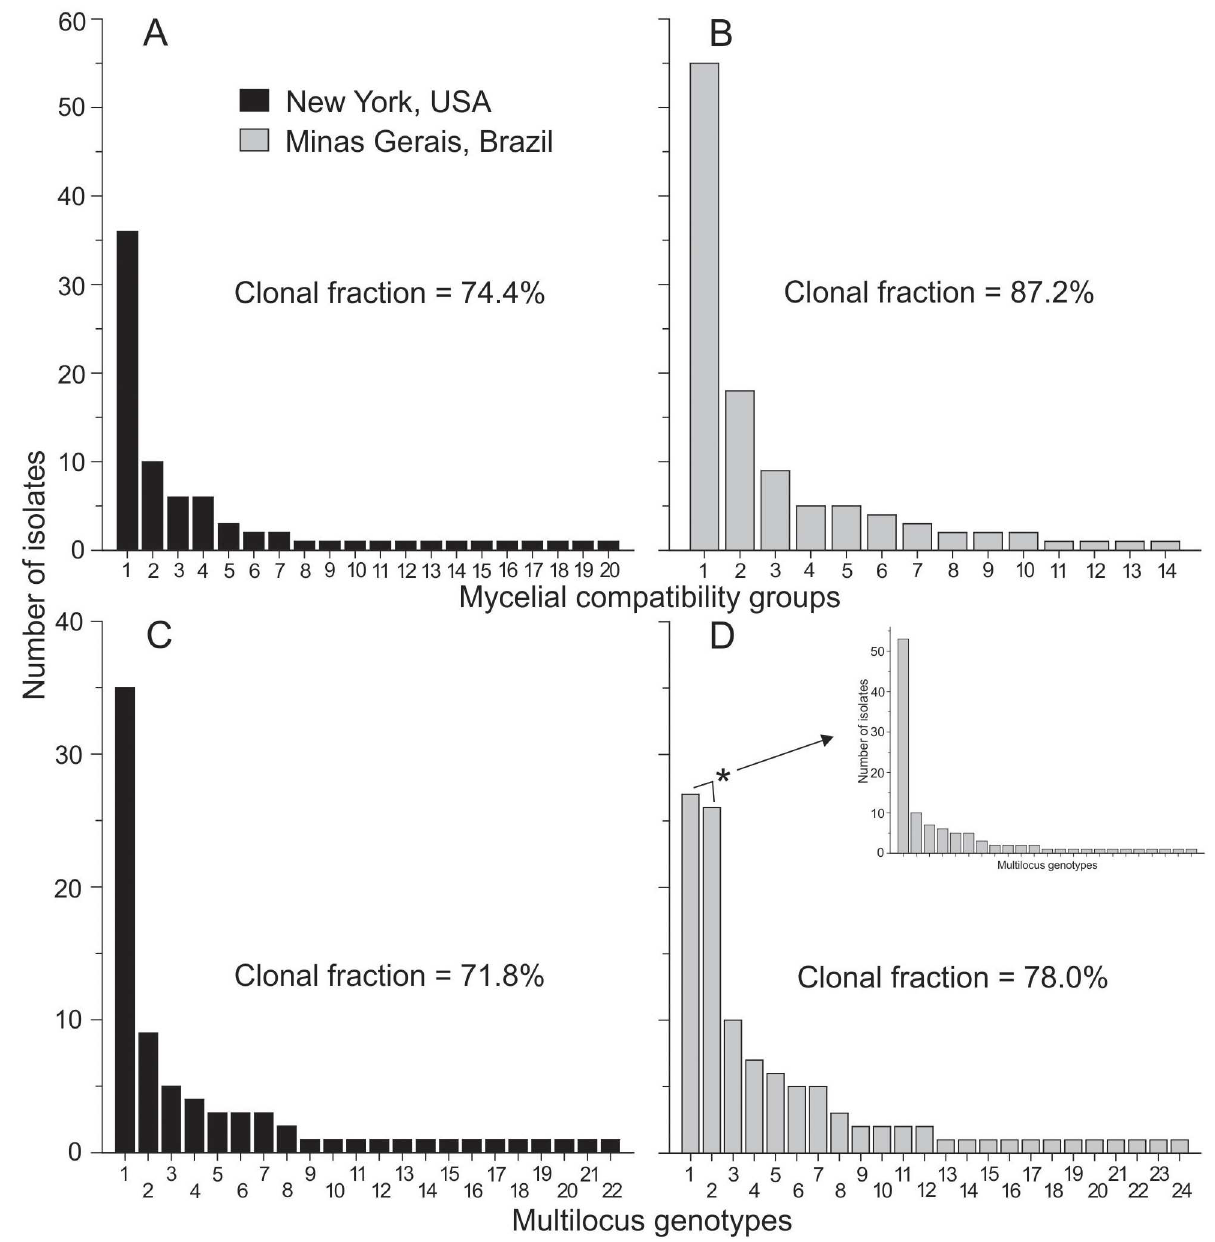
Fig 1. Frequency of the mycelial compatibility groupings (A and B) and multilocus genotypes (MLGs) (C and D) obtained from 13 microsatellite loci in the Sclerotinia sclerotiorum populations from New York, USA, and Minas Gerais, Brazil. The asterisk indicatesthe sum of the frequencies of two closely related MLGs, with a difference at the 8–3 locus (dinucleotide repeats). The MLG 1 has a 250 base pair (bp) allelewhile the MLG 2 has a 252 bp allele.